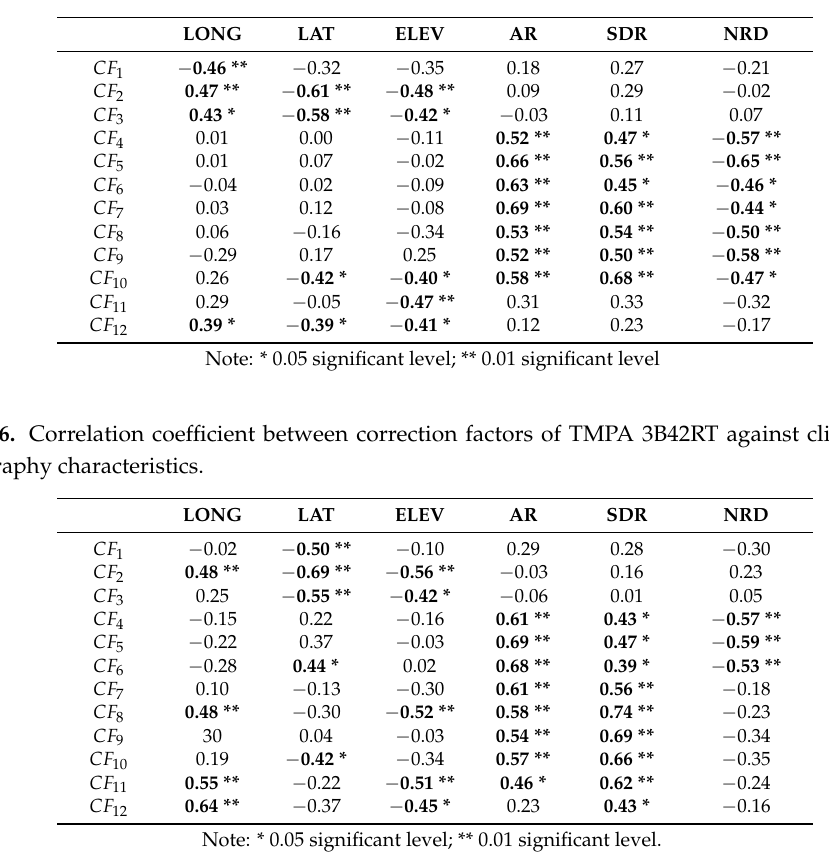
Table 5. Correlation coefficient between correction factors of TMPA 3B42V7 against climatology– topography characteristics.